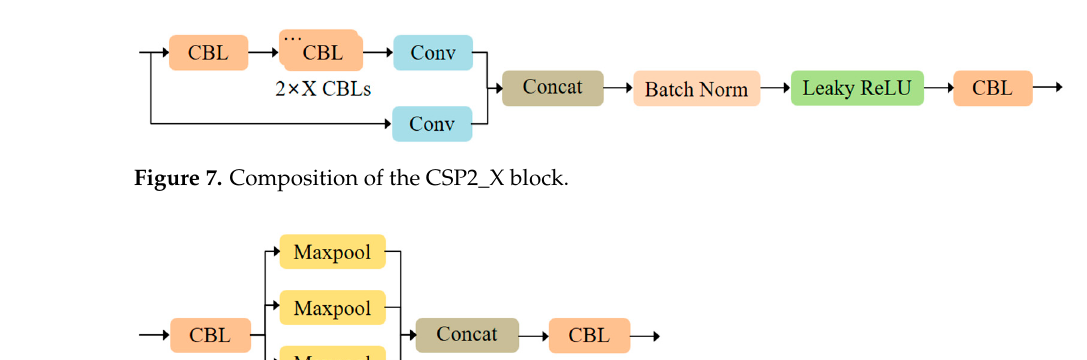
Figure 6. Composition of the residual unit block .